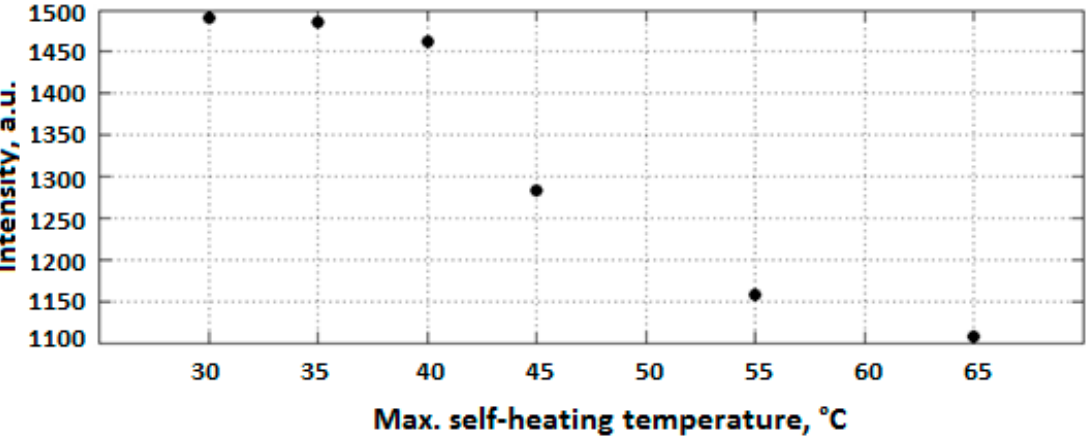
Figure 34. Intensity of Raman band versus self-heating temperature induced during fatigue loading for epoxy [1,113].